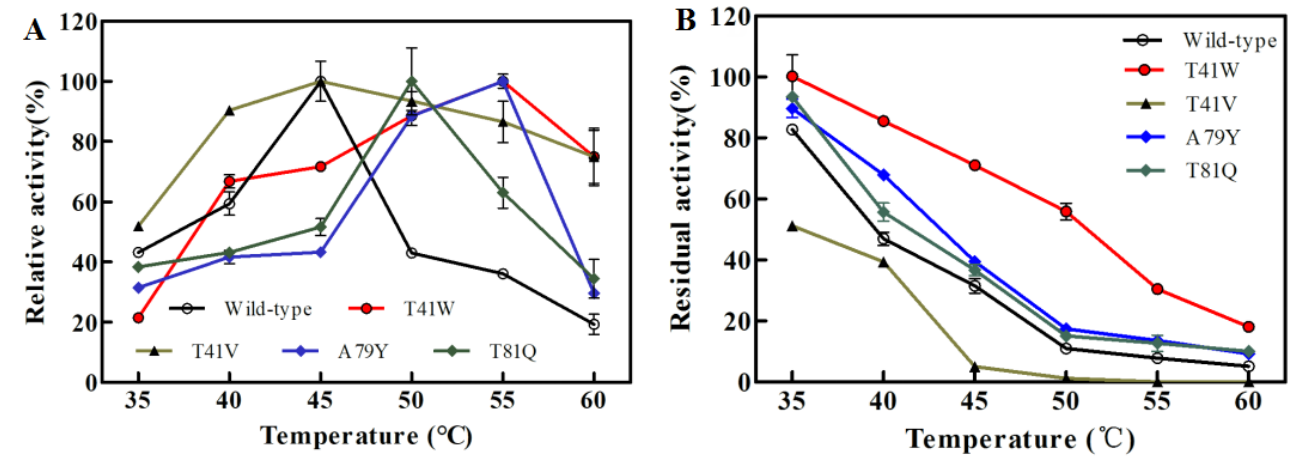
Figure 3. Optimal temperature ( A ) and thermostability ( B ) of the wild-type XynASP and four single mutants. The data for the wild-type and T41W was adapted with permission from Ref. [28]. 2022, Bio Tech System. The highest activity of each wild-type and mutant was set as 100%.